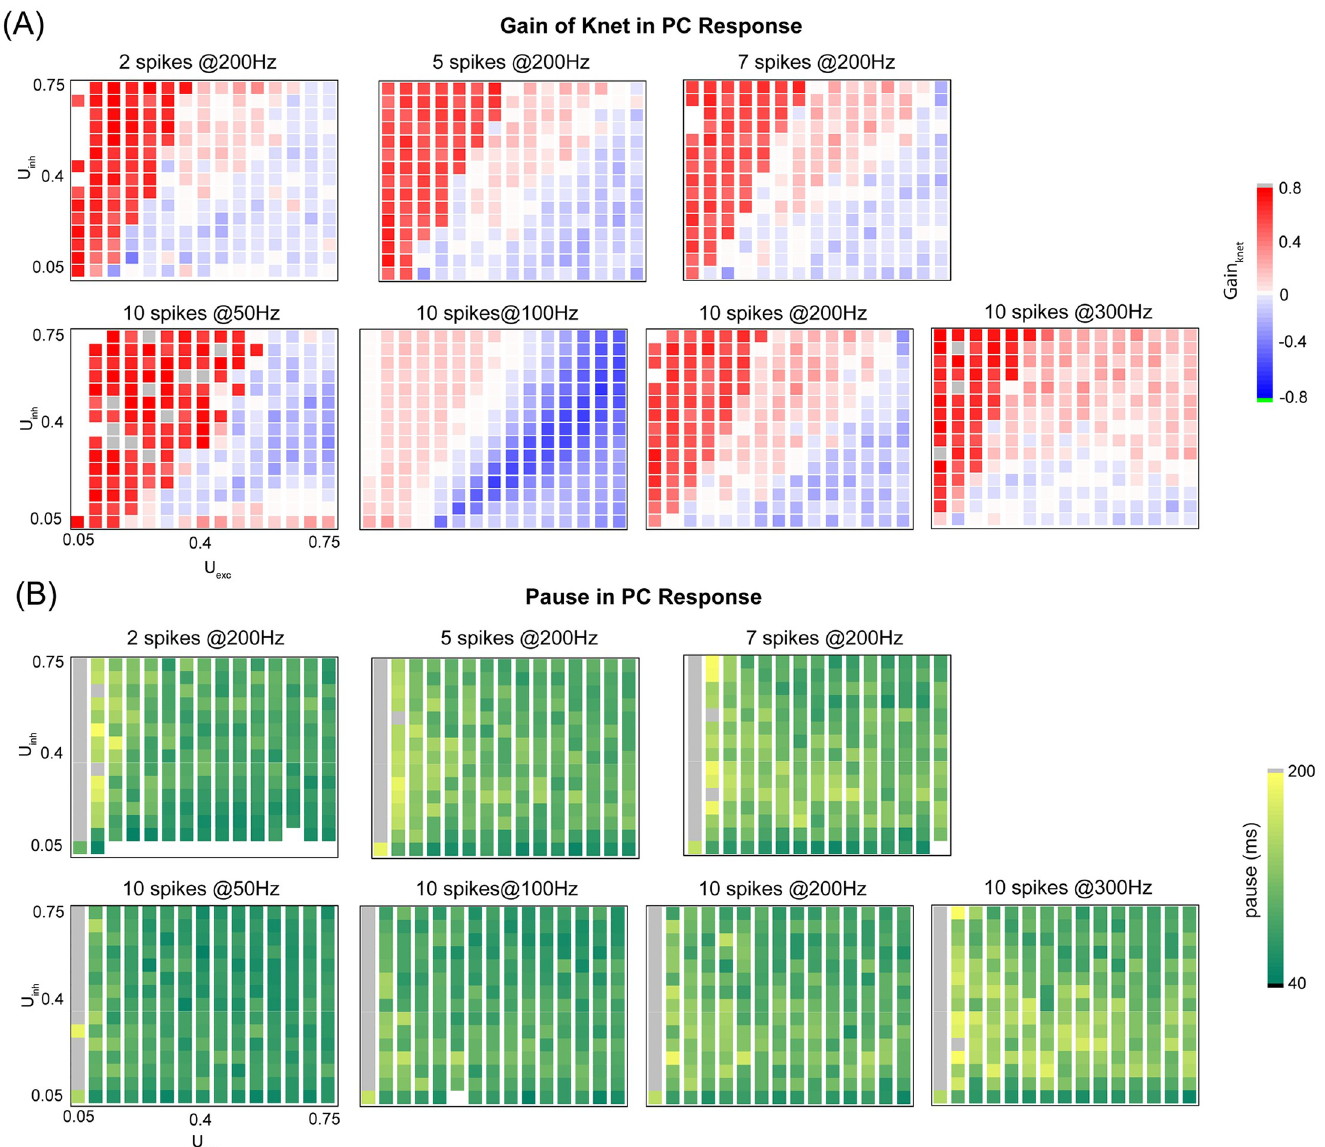
Fig 10. PC synchronization is controlled by STP of both excitation and inhibition, whereas PC pause response is less dependent on STP of inhibition. (A) The gain of synchronization regulated differently by STP of ML-PC inhibition U inh and excitation GC-PC U exc under bursts with different spikes and frequencies. Each inner rectangle in each panel represents the gain of network synchronization under one burst protocol. (Top) Bursts with 2, 5 and 7 spikes at fixed 200 Hz. (Bottom) Bursts with 10 spikes at 50, 100, 200 and 300 Hz. Note that the gain was defined as the relative change calculated by the average K net with STP subtracted by that without STP. (B) Similar to (A) but for pause duration induced by